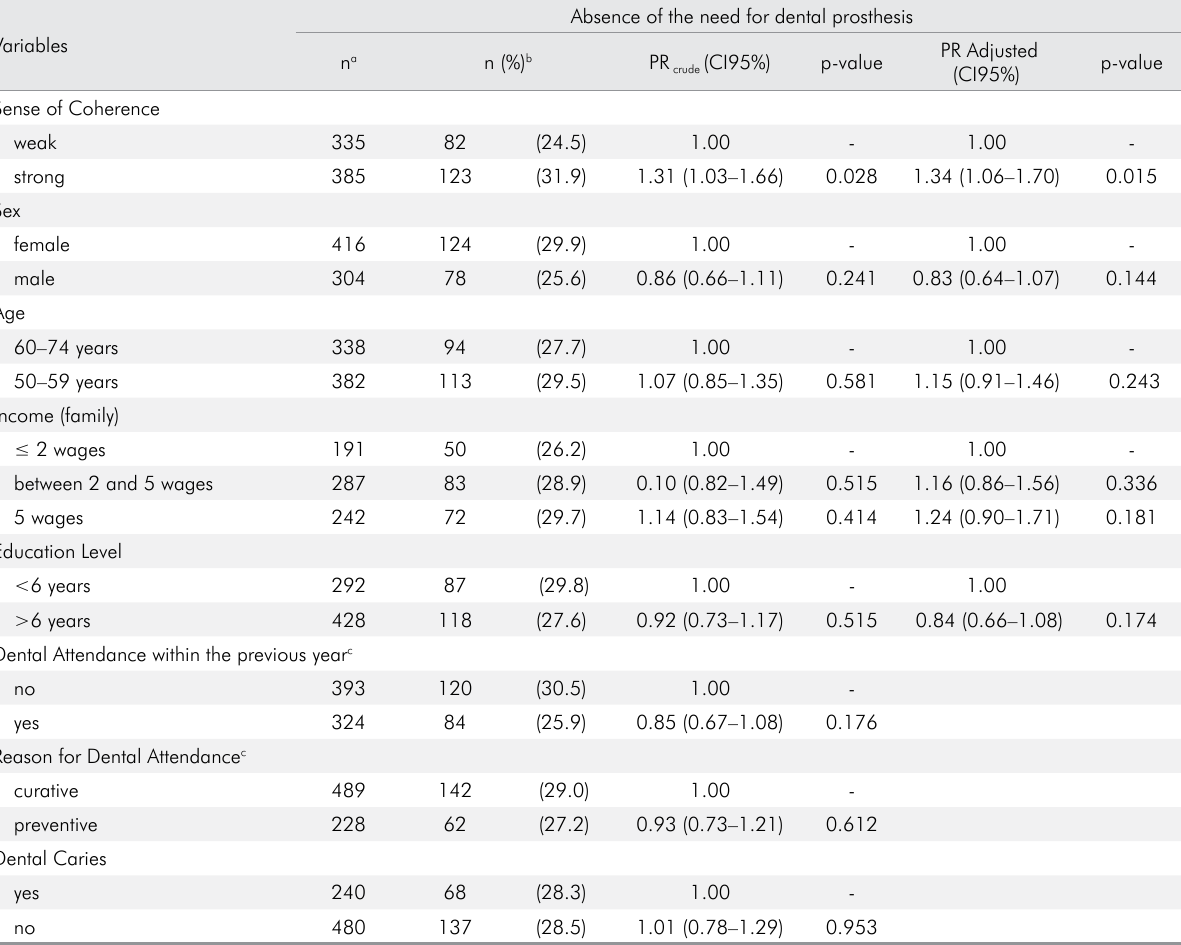
Absence of the need for dental